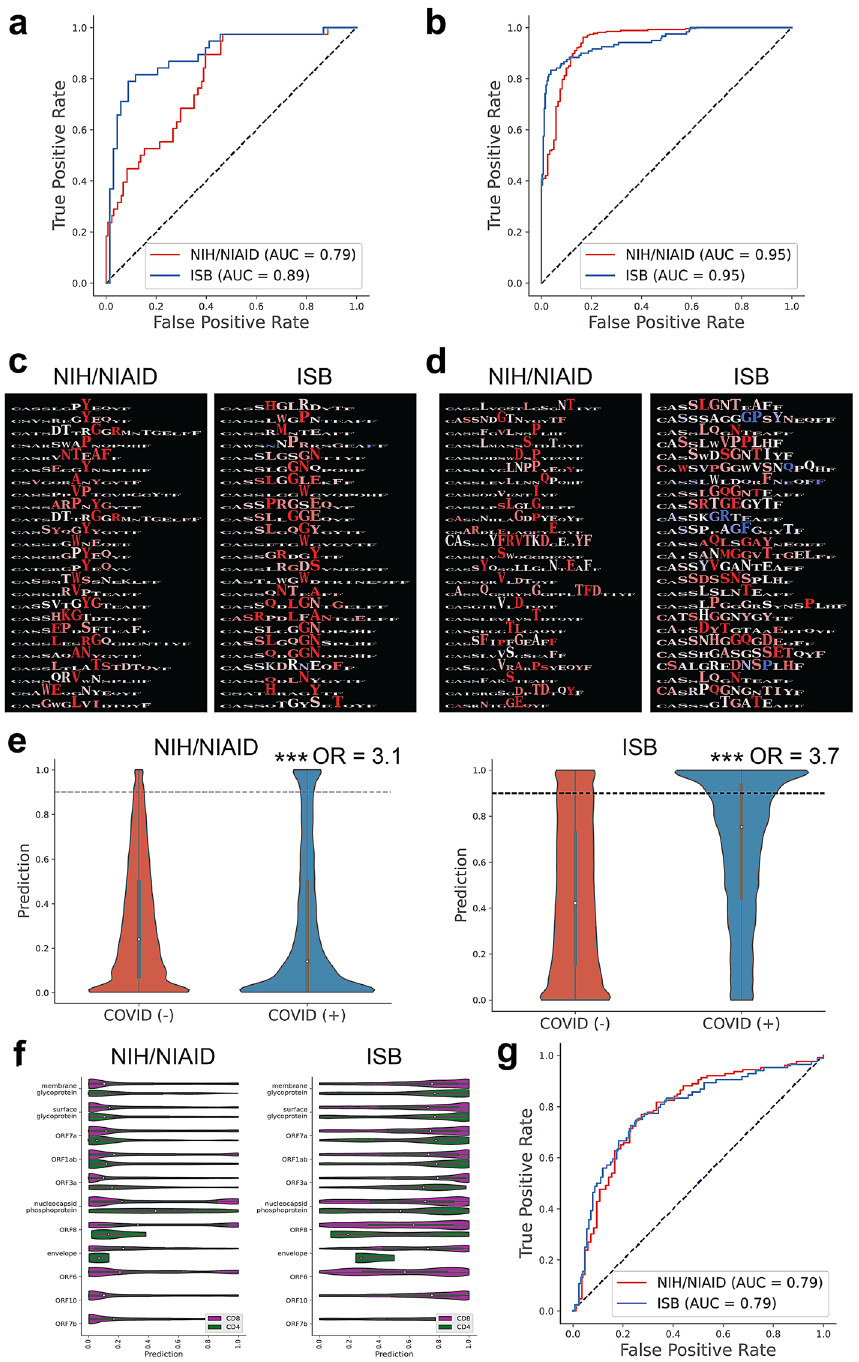
Figure 2. Deep learning models identify TCR signature of severe disease. ( a ) DeepTCR’s multiple instance repertoire classifier was used to fit predictive models of severe/mild illness in Monte Carlo cross-validation across both the NIH/NIAID and ISB cohort of patients. Receiver Operating Characteristic (ROC) curves are shown with corresponding Area Under Curve (AUC) measurements. ( b ) DeepTCR’s repertoire classifier was also fit to identify TCR repertoire differences between samples taken from the NIH/NIAID or ISB cohort. Receiver Operating Characteristic (ROC) curves are shown with corresponding Area Under Curve (AUC) measurements. ( c ) Following model fitting, top predictive sequences for severe disease were extracted from the network and residue sensitivity logos (RSL’s) were created highlighting predictive residues. ( d ) Following model fitting, top predictive sequences for NIH/NIAID versus ISB cohorts were extracted from the network and residue sensitivity logos (RSL’s) were created highlighting predictive residues. ( e ) All TCR sequences present in the samples were mapped to being COVID(+) or COVID(−), based on empirically derived antigen- specificity data from the MIRA assay and plotted by their corresponding prediction values for severe illness. A threshold of P = 0.90 was used to create contingency tables of TCR sequences called to carry the severe disease as well as the COVID(+) signature and used to calculate enrichment scores (Fisher’s Exact Text: *** p val < 0.001). ( f ) COVID(+) sequences were further stratified by open reading frame (ORF) in the viral genome as well as by CD8/CD4 specific TCRs as provided by the MIRA assay. ( g ) SARS-CoV-2 specific TCR sequences, as determined from MIRA assay results in the ImmuneCODE database were collected and mapped to their corresponding epitope sequences and used in place to train the repertoire classifier. Receiver Operating Characteristic (ROC) curves are shown with corresponding Area Under Curve (AUC)